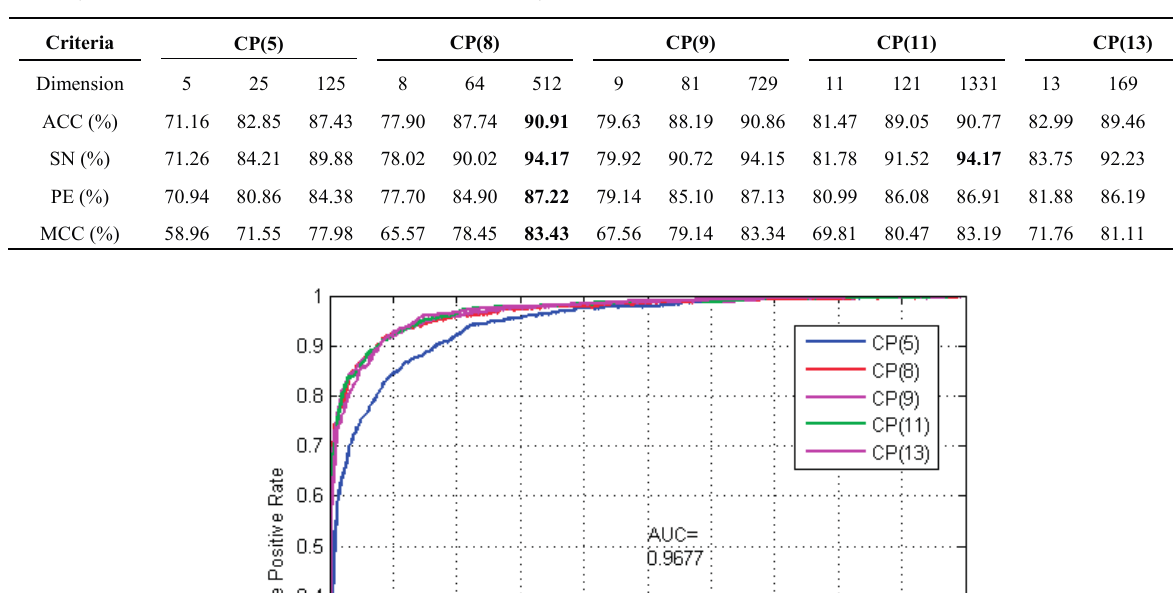
Table 3. Five-fold cross-validation results of protein–protein interactions (PPIs) prediction. ACC, accuracy; SN, sensitivity; PE, precision; MCC, Matthews correlation coefficient. (The numbers in bold is the best result.).